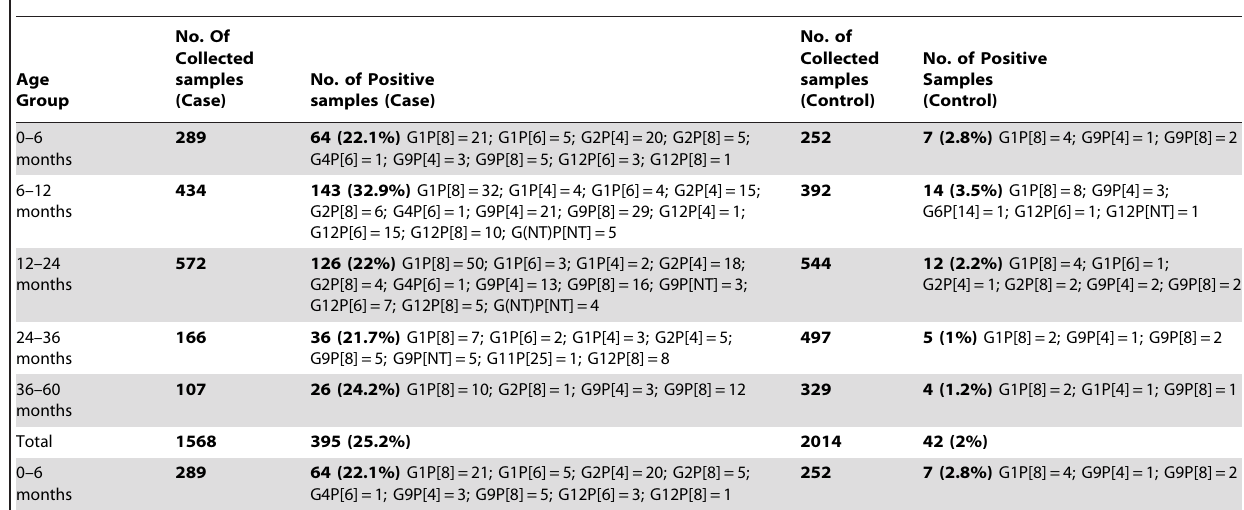
Table 2. Age and type wise distribution of Rotavirus positive Case and Control stool samples (During the year 2008 through 2010).